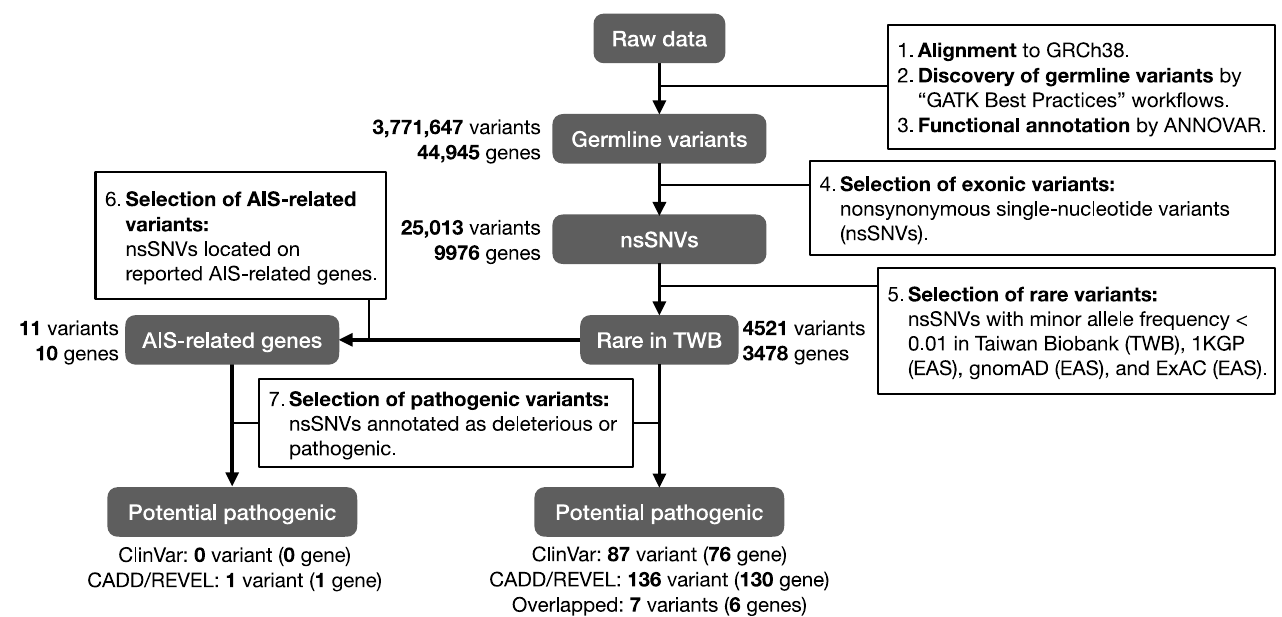
Figure 1. Workflow of the AIS WES analysis. Sequencing reads were aligned to the GRCh38 reference genome and variants were called using GATK Best Practices workflows. Nonsynonymous single-nucleotide variants with minor allele frequency <0.01 were selected. Genes include rare variants were compared with previous AIS-related genes. Rare variants annotated as pathogenic were selected for further